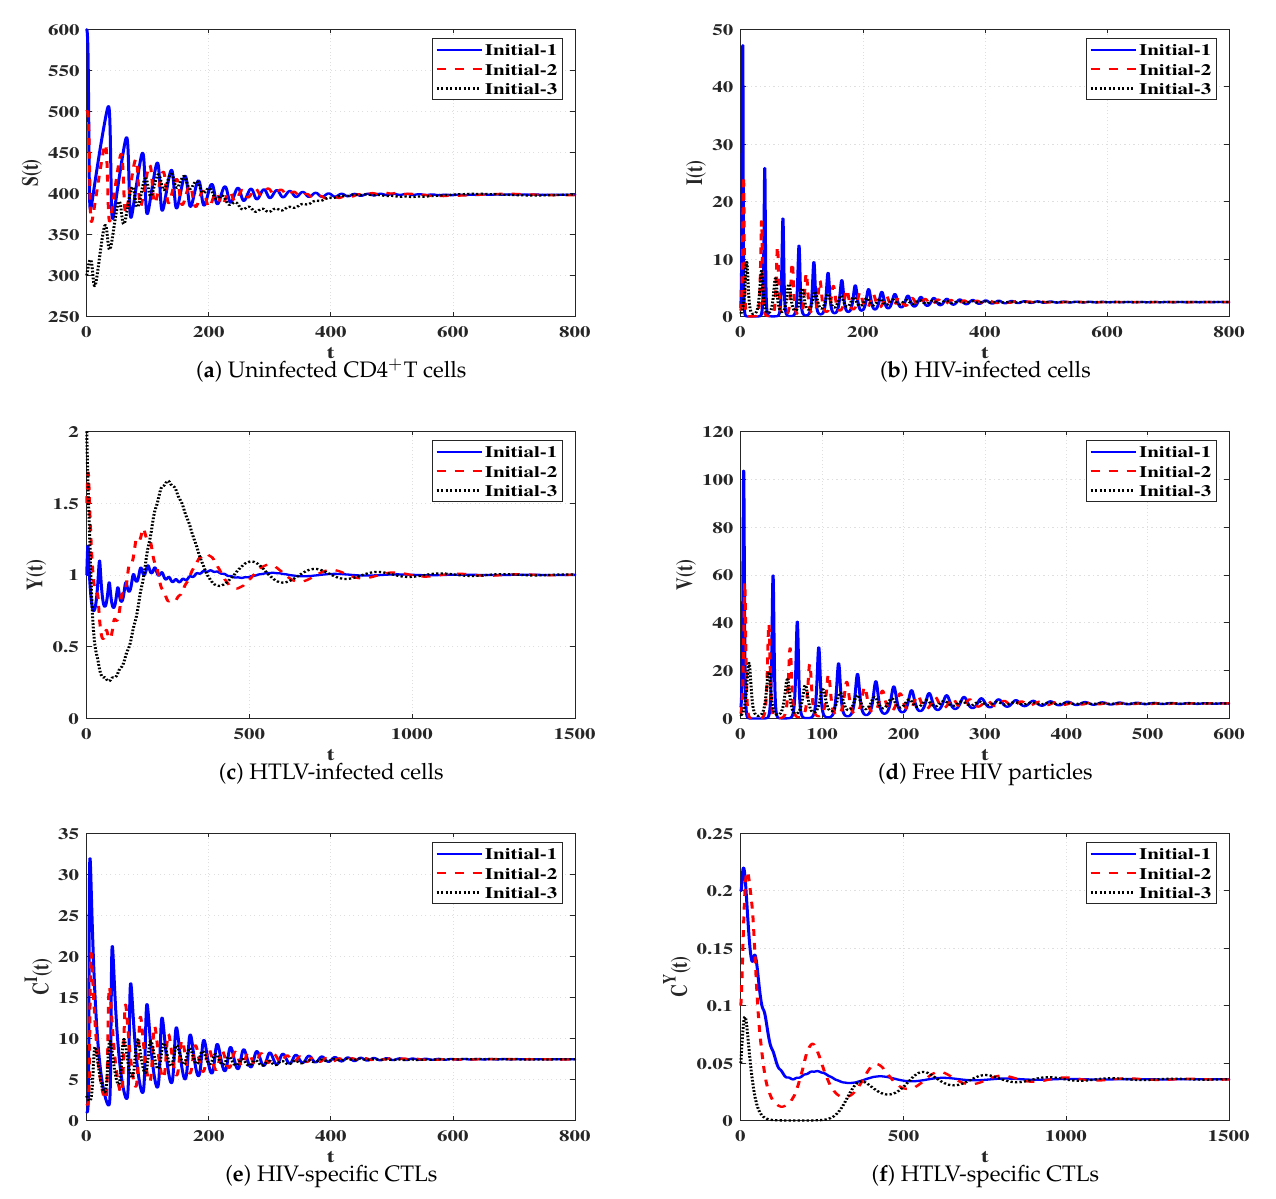
Figure 9. Solutions of system (4) when (cid:60) 7 > 1 and (cid:60) 8 > 1. Then, we compute the eigenvalues λ i , i = 1, 2, ..., 6 of J at each steady state. The steady state is locally stable if the eigenvalues satisfy Re ( λ i ) < 0, for all i = 1, 2, ..., 6. We use the values of the parameters η 1 , η 2 , σ 1 , and σ 2 given in Sets 1–8 and compute all non-negative steady states and the corresponding real parts of the eigenvalues (see Table 4). The local stability results agree with the global stability results given in Theorems